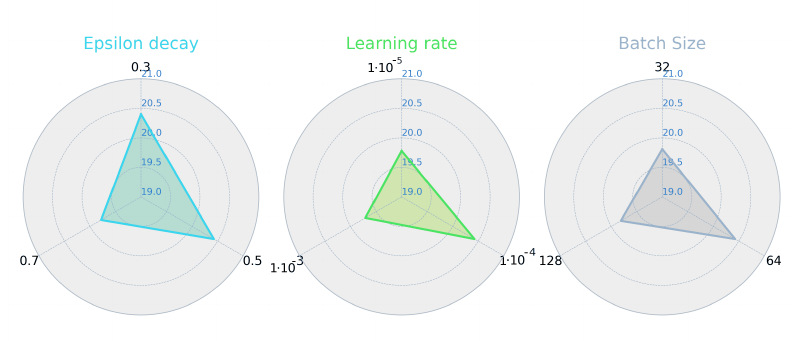
Figure 13. Max. reward obtained for the greedy parametrization in the DDQL